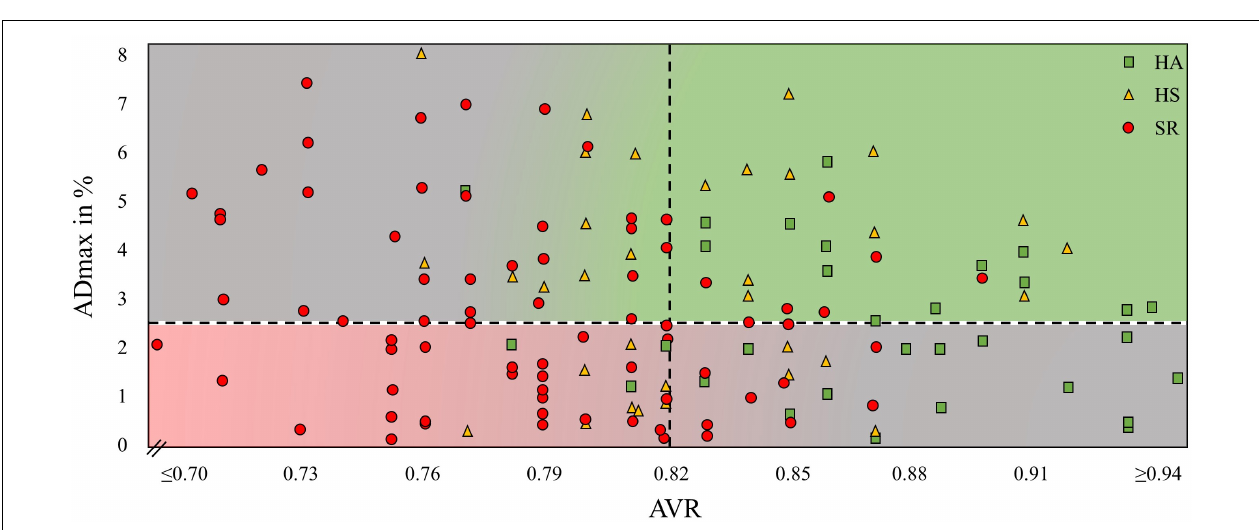
FIGURE 4 | Maximal arteriolar dilatation in % (ADmax) and arteriolar-to-venular diameter ratio (AVR) of every study participant. HA, healthy active; HS, healthy sedentary; SR, sedentary patients with increased CV